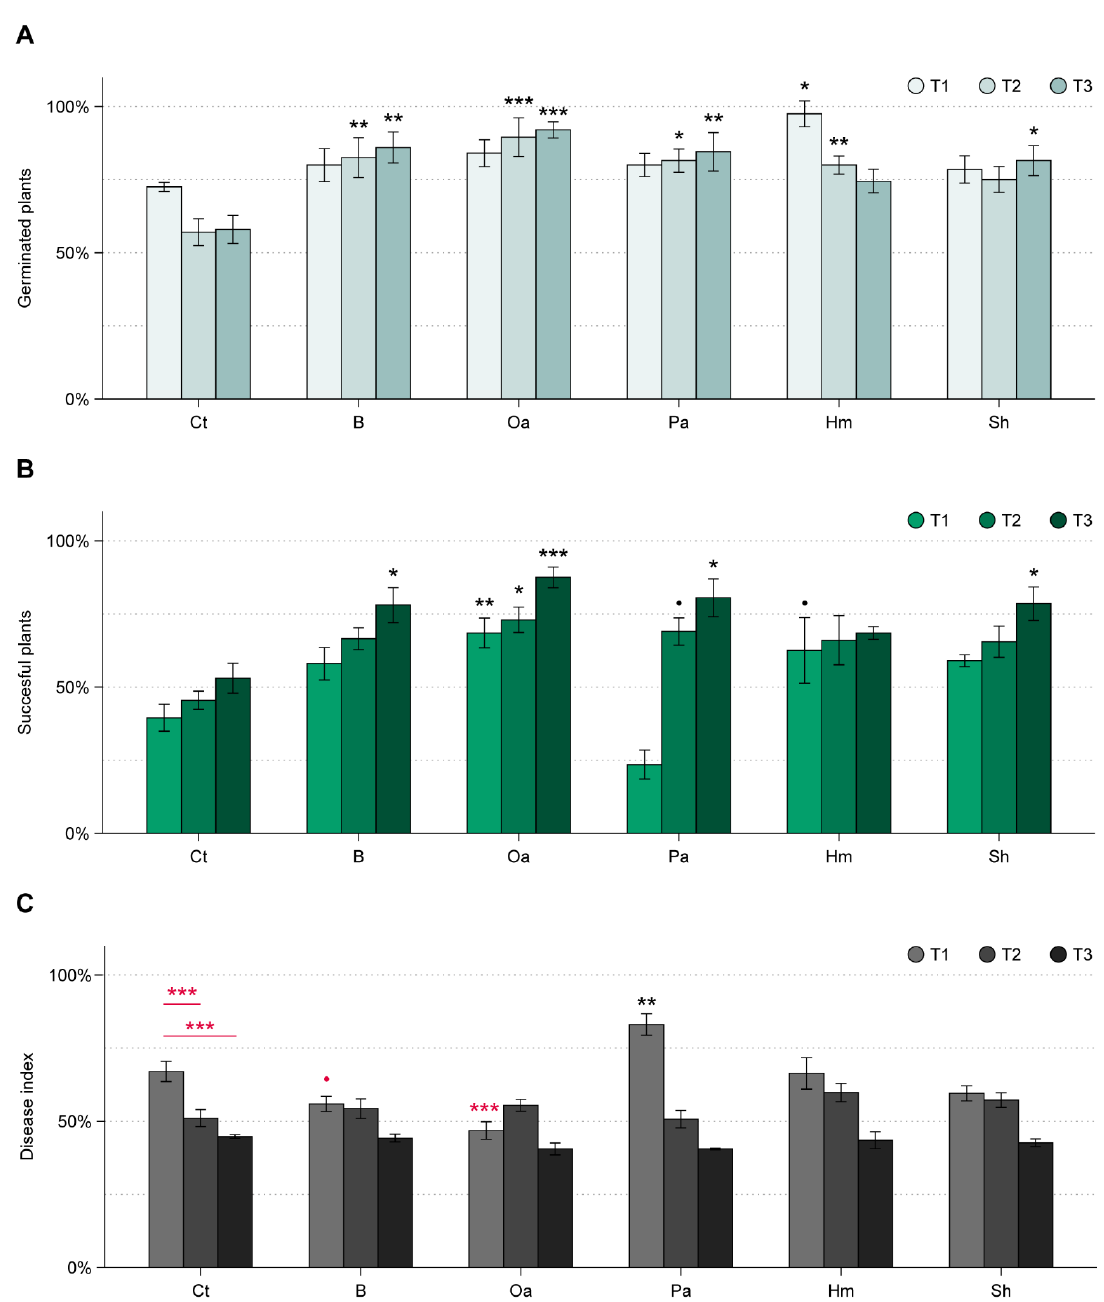
Figure 6. Performance of beetroot seedlings in soil amended with five organic materials, with three time intervals (T1 = 1 day, T2 = 14 days, T3 = 28 days) between amendment and sowing (ToS experiment). Soil treatments are indicated as: Ct = control, B = beech sawdust, Oa = oak sawdust, Pa = paper pulp, Hm = hair meal, Sh = shrimp meal. ( A ) Percentage of germinated seeds and ( B ) percentage of seeds that resulted in successful plants. ( C ) Disease severity index. All measurements are shown as mean ± se , n = 5 for each treatment and sowing time. Significant differences between each treatment and the control within each time interval (Dunnett’s test), and among time intervals for the control (Dunnett’s test), are indicated as • 0.1> p >0.05; * 0.05> p >0.01; ** 0.01 > p > 0.001, *** p < 0.001. Significant increases and decreases are shown with black and red symbols, respectively.